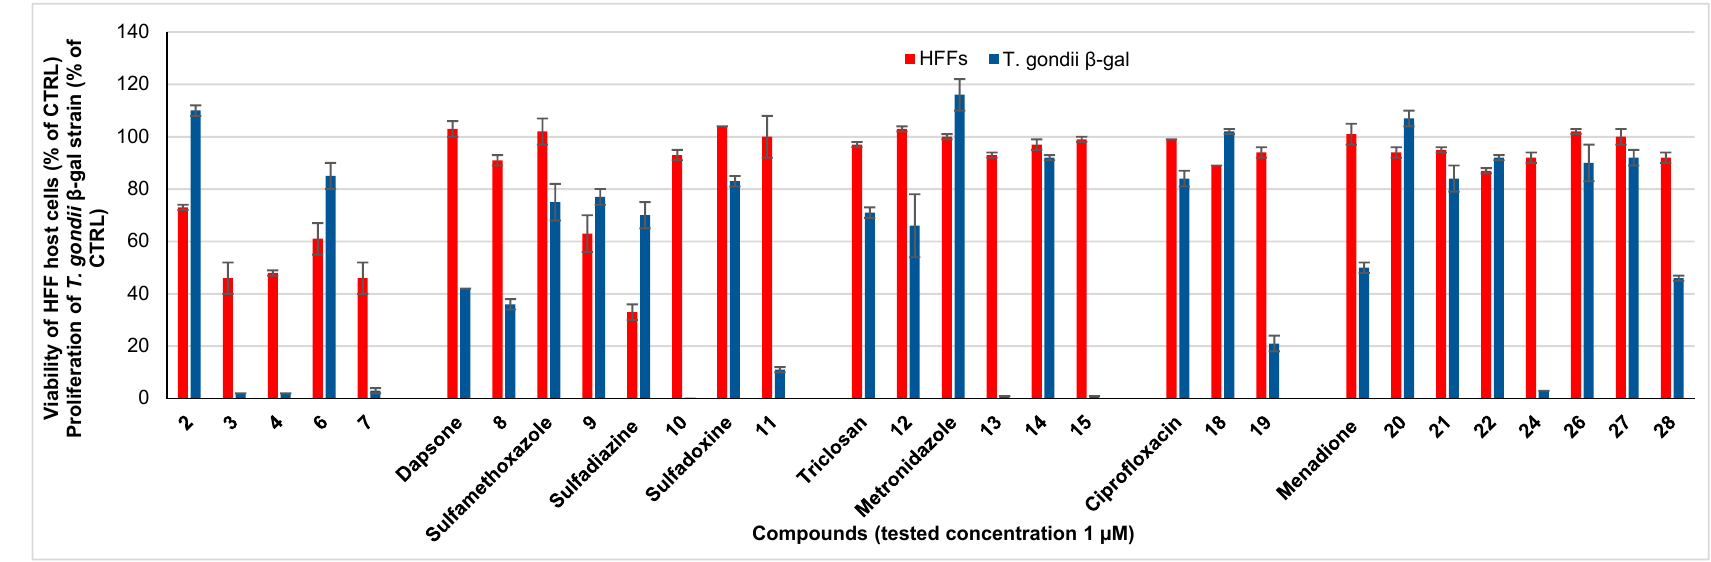
Figure 6. Clustered column chart showing the in vitro activities at 0.1 ( A ) and 1 µ M ( B ) of the 30 tested compounds on HFF viability and T. gondii β -gal proliferation. Noninfected HFF monolayers treated only with 0.1% DMSO exhibited 100% viability and 100% proliferation was attributed to T. gondii β -gal tachyzoites treated only with 0.1% DMSO. Red bars represent viability values of HFF, and blue bars represent the proliferation of T. gondii β -gal tachyzoites. For each assay, standard deviations were calculated from triplicates and are displayed on the graph. Data for compounds 2 – 4 and 6 were previously reported in [30,43,80]. Complex 5 exhibited no activity against the parasite [30] (values not shown).